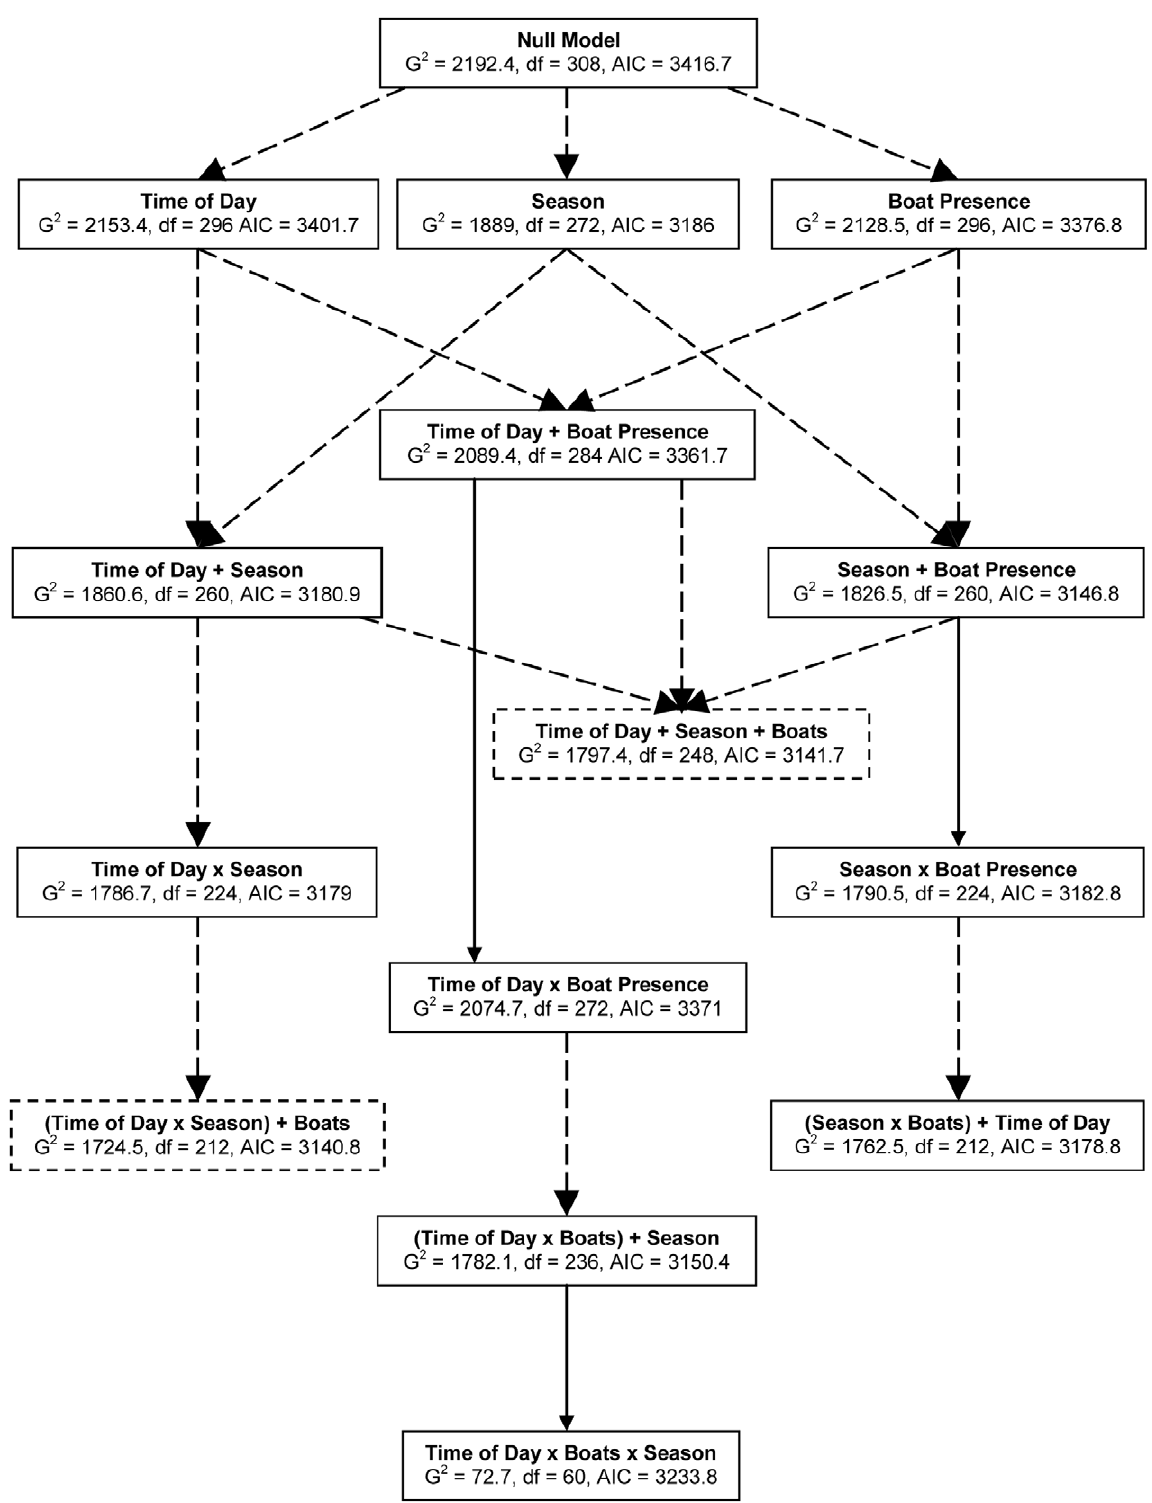
Figure 2. Effects of vessel presence, time of day, and seasons on behavioural state transitions. The null model (no effects due to the three factors) is at the top, and each branch below adds an effect due to a factor or interaction between factors. Boxes represent the model tested, with G 2 , degrees of freedom (df), and Akaike Information Criteria (AIC) values listed. An ‘x’ between two terms indicates that their interaction is included. Dashed arrows indicate significant terms added (p , 0.05). Dashed boxes indicate the best fitting models determined by AIC values.